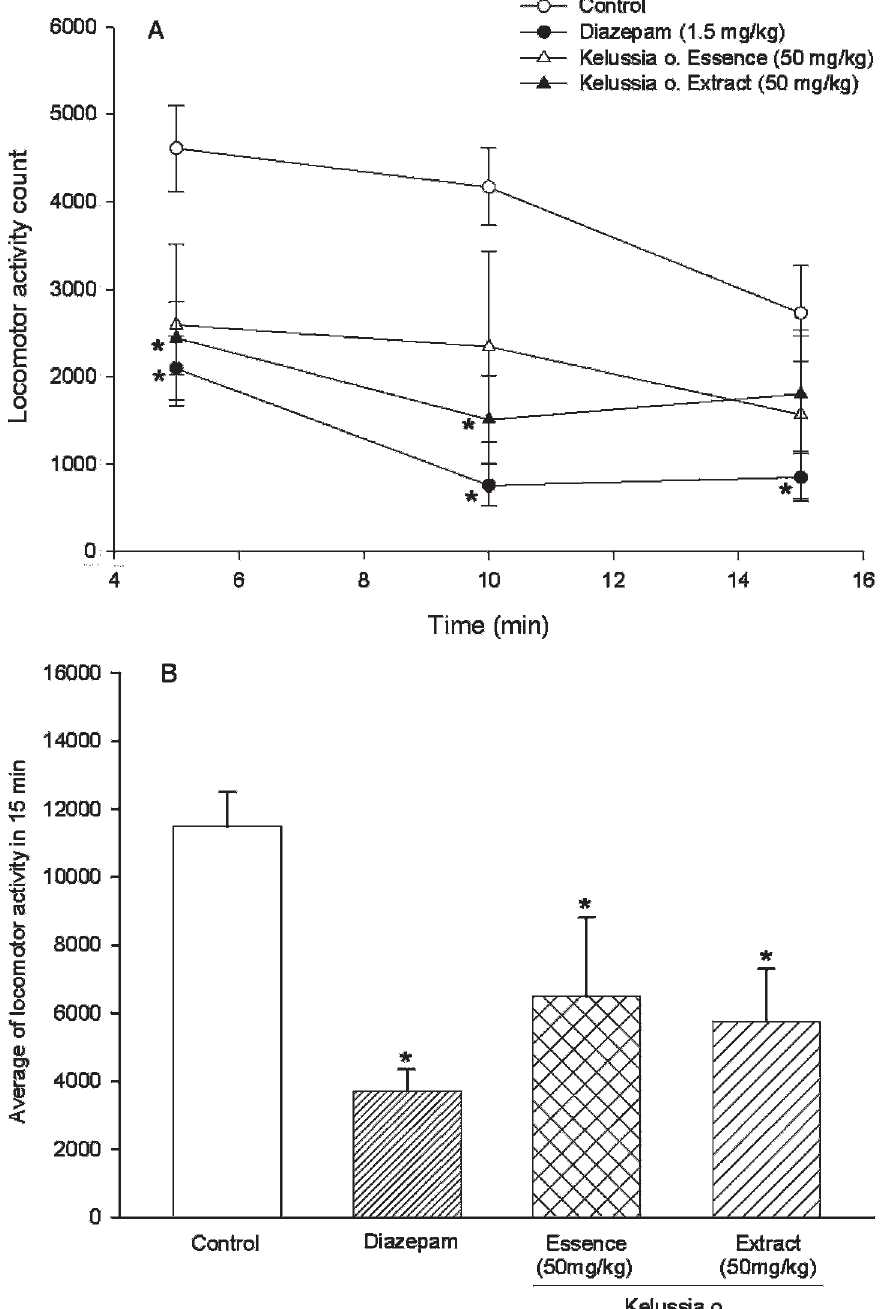
Figure 2 - The effects of diazepam, vehicle, and different doses of K. odoratissima essential oil and extract on (A) spontaneous locomotor activity during three 5-min intervals and on (B) spontaneous locomotor activity during the total 15 min of testing. The locomotor activity counts (mean ¡ SEM) were measured over a 15-min period beginning 30 min after the administration of vehicle, diazepam, plant essential oil or extract. Data are presented as mean ¡ SEM for each group of 6 mice. * p , 0.05 compared to